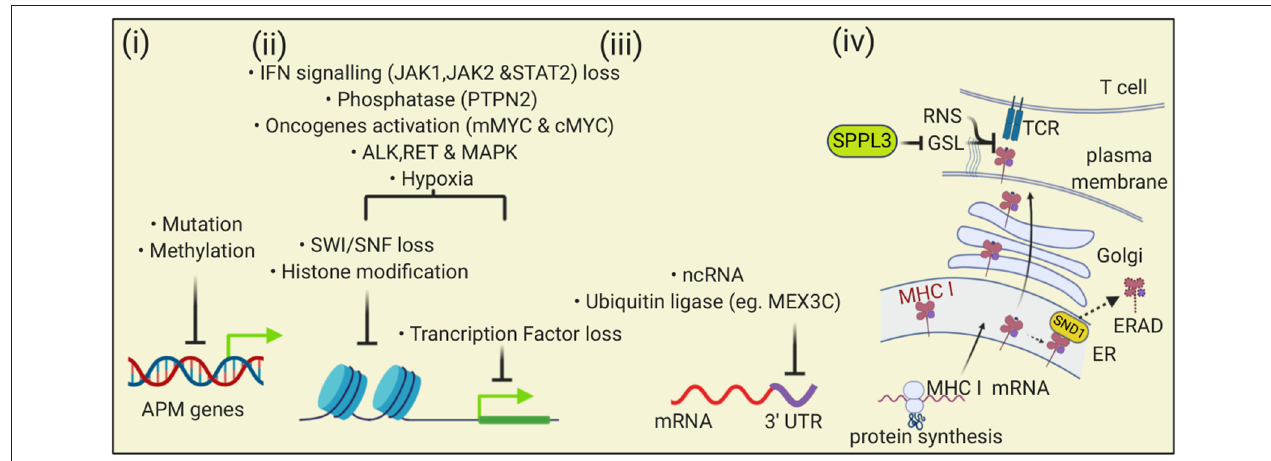
FIGURE 7 | The MHC I antigen presentation pathway is down-regulated by multiple mechanisms in cancers. (i) At the level of DNA, mutation and methylation of nucleotides can reduce expression of APM genes; (ii) Transcription of APM can be reduced by changes in chromatin that impair gene accessibility or through loss of transcription factors. Multiple mechanisms can affect these processes including altered signaling pathways, oncogene activity, and the tumor microenvironment; (iii) At the level of transcription, binding of ncRNA or proteins to the 3 ′ UTR of APM mRNAs can reduce transcription; (iv) At the level of protein, Staphylococcal nuclease and tudor domain containing 1 (SND1) can bind to MHC I in the ER and trigger endoplasmic reticulum-associated degradation (ERAD). At the cell surface, loss of SPPL3 increases glycosphingolipids (GSL) that then sterically inhibit MHC I and TCR interactions. Reactive nitrogen species can nitrosylate peptide-MHC I complexes in ways that impair TCR